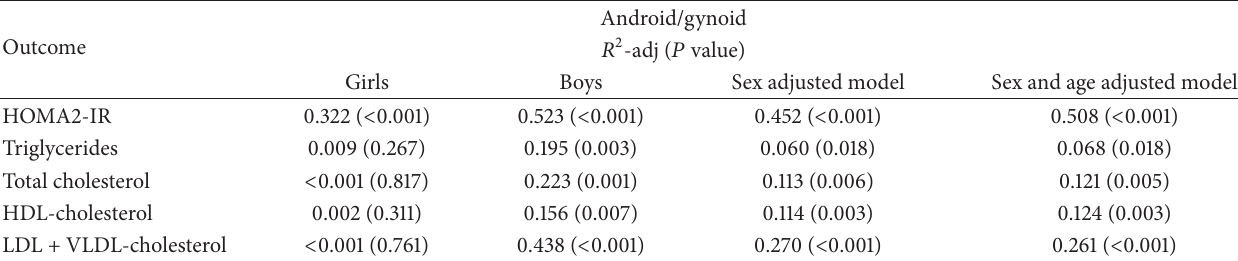
Table 3: Regression based correlation analyses adjusted 𝑅 2 between android/gynoid ratio and our metabolic and cardiovascular risk factors. Regression models for each sex as well as a sex adjusted and a sex and age adjusted regression